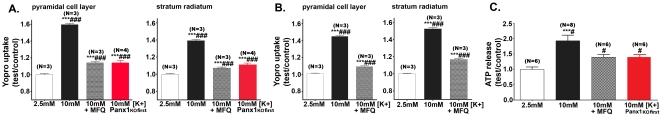
Blockade or deletion of Panx1 channels prevents membrane permeabilization of hippocampal neurons and astrocytes and attenuates ATP release from brain slices.Bar histograms showing the fractional mean ± s.e.m. values (test/control: normalized to 2.5 mM K+ ACSF) of YoPro1 uptake induced by 10 mM K+ in the pyramidal cell layer and stratum radiatum obtained in the absence and following (A) slice incubation and (B) animal injection with MFQ. A substantial reduction in dye uptake was recorded from slices of Panx1 KOfirst mice exposed to high K+ ACSF (red bars). (C) Bar histograms showing the fractional mean ± s.e.m. amounts of ATP present in the bathing solution of hippocampal slices exposed for 1 hr to ACSF containing either 2.5 or 10 mM K+. Note the increased release of ATP in 10 mM K+ and its reduction following the blockade (MFQ: 100 nM) and deletion (Panx1 KOfirst mice) of Panx1 channels. Data displayed in panels A and B are from 3 wild type and 4 Panx1 KOfirst mice per group. The number of animals used in part C is in parentheses. ***P<0.001 and *P<0.05 between control and test conditions; ###P<0.001, ##P<0.01, and #P<0.05 between test conditions. P values were obtained from One-way Anova analysis of variance followed by Bonferroni's multiple comparison tests.